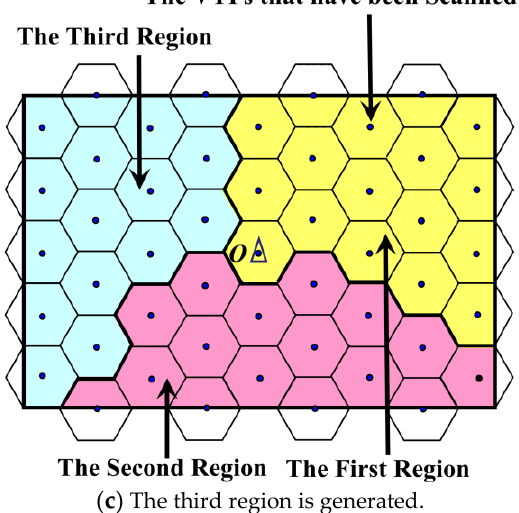
Figure 13. The network partition based on virtual scan line.